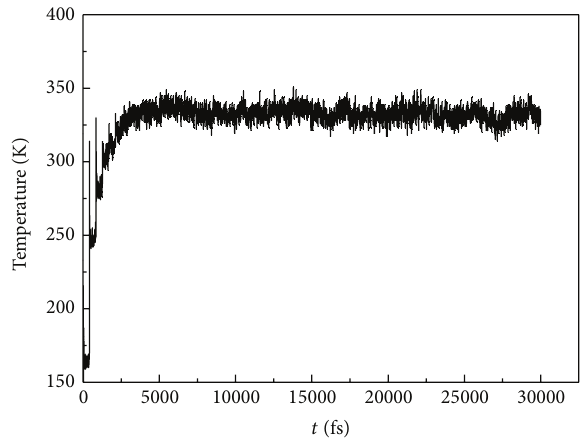
Figure 2: Temperature with the system optimization.